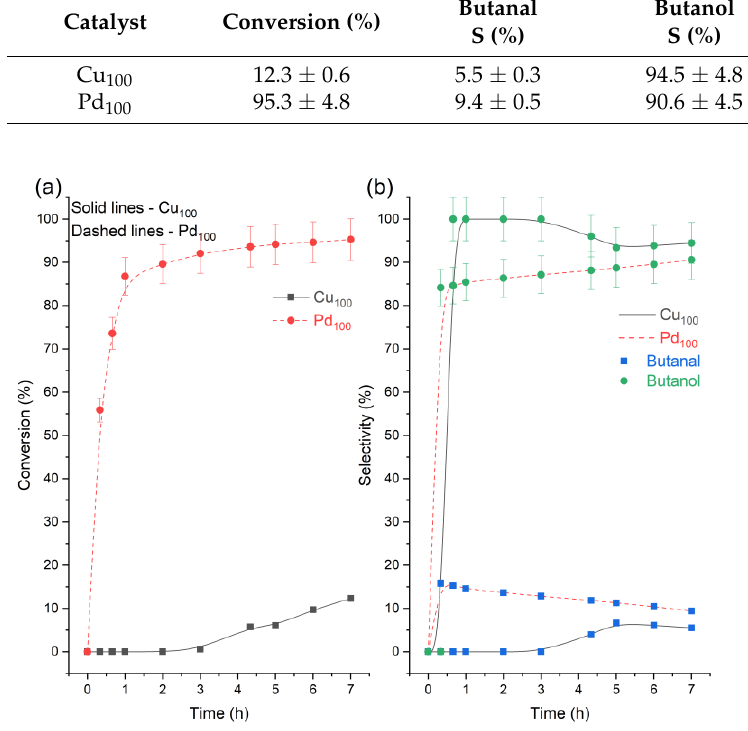
Figure 4. Reaction profiles for the hydrogenation of crotyl alcohol. ( a ) crotyl alcohol conversion and ( b ) product selectivity across the monometallic catalysts. Reaction conditions: 7 h, 50 °C, 1.5 bar H 2 , 600 RPM, and 10 mg of catalyst.